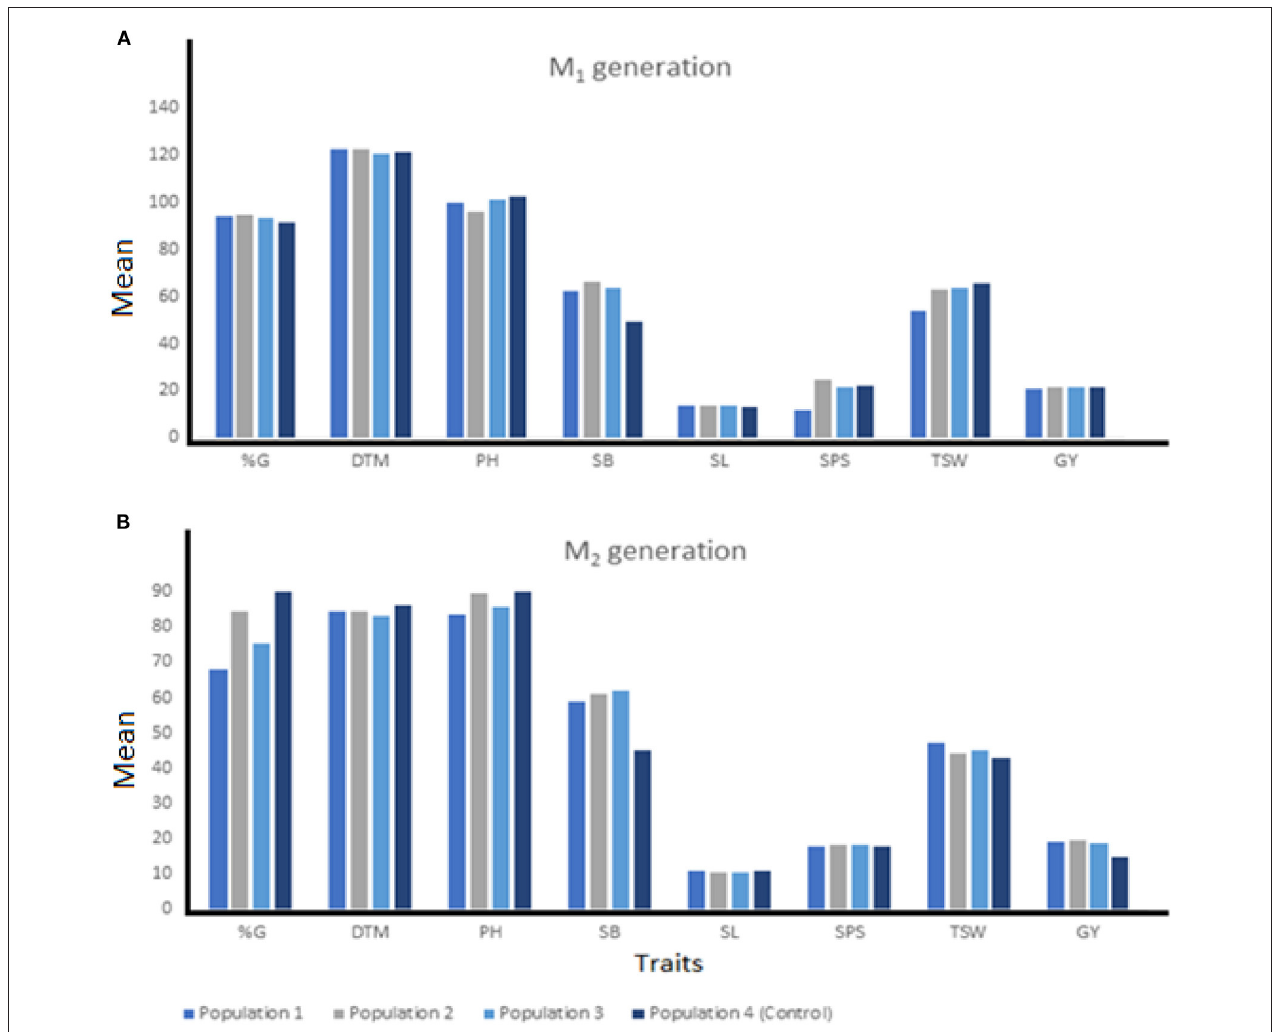
FIGURE 2 | The means of individuals among three EMS-treated and control populations of wheat at M 1 (A) and M 2 (B) generation. %G, percentage germination; DTM, days to 90% maturity; PH, plant height; SB, shoot biomass; SL, spike length; SPS, number of spikelets per spike; TSW, 1000-seed weight; GY, grain